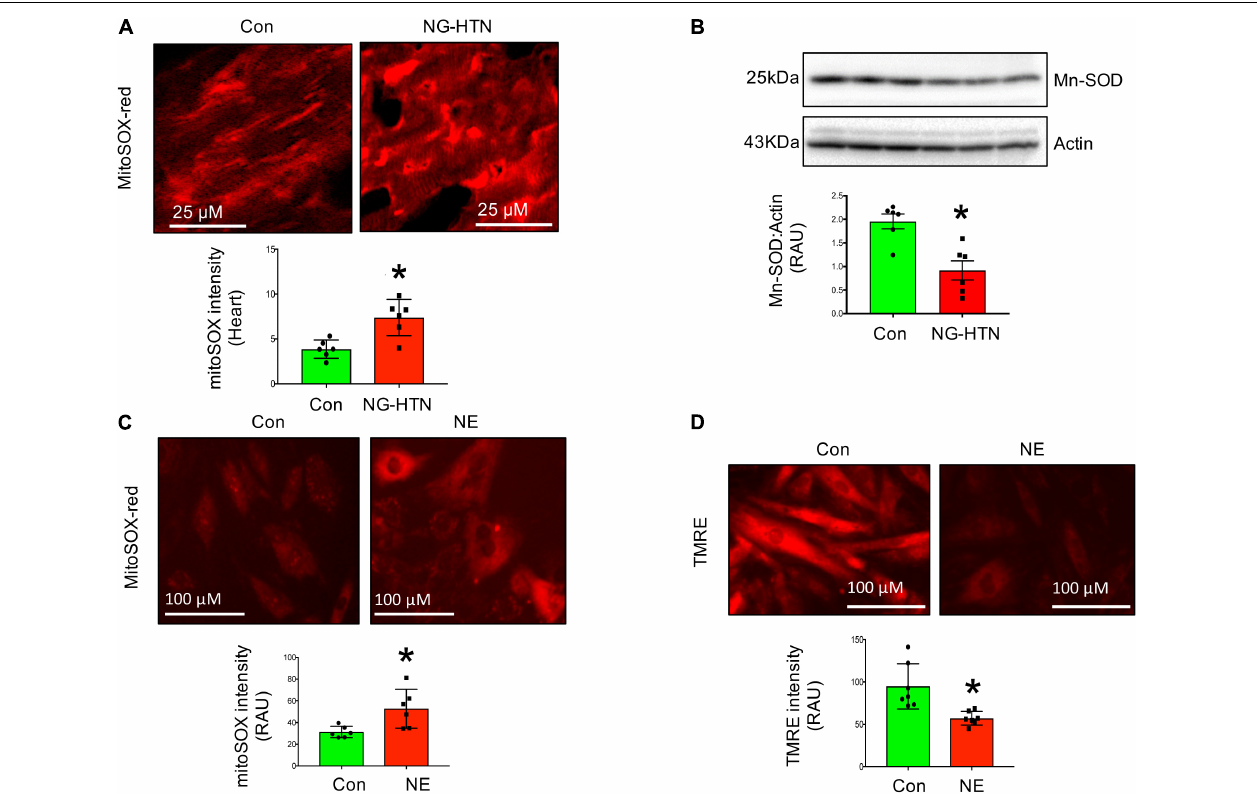
FIGURE 4 | Neurogenic hypertension and cardiac mitochondrial quality control events. (A) Top, Mito-SOX red (mitochondrial ROS marker) staining of control and NG-HTN heart sections. Bottom, quantification of Mito-SOX intensity. (B) Western blot to assess Mn-SOD protein level in control and NG-HTN whole hearts lysate, bottom, WB quantification of Mn-SOD. (C) Live cell Mito-SOX imaging and quantification showing Mito-SOX intensity in control and NE-treated H9c2 cardiomyocytes. (D) Live cell TMRE imaging and quantification showing mitochondrial membrane potential ( (cid:49)(cid:57) m) in control and NE-treated H9c2 cardiomyocytes. Values are mean ± SEM, n = 6 rats, * P < 0.05 vs. Control, Student’s t